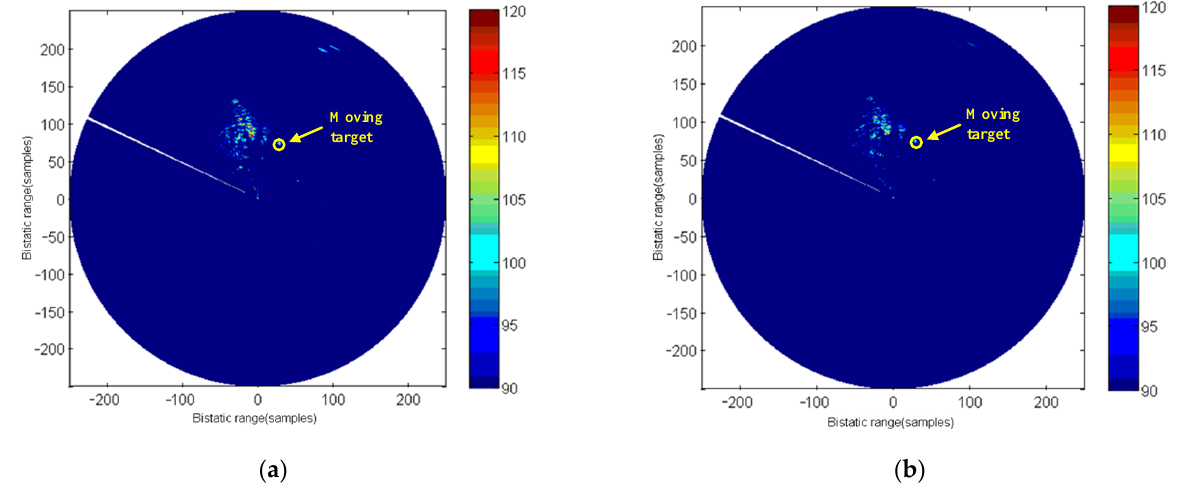
Figure 25. HBRmap after clutter cancellation processing: ( a ) ME-CM; ( b ) SPFB-CM.